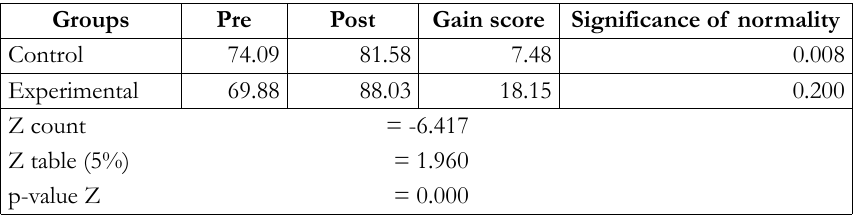
Table 7. The Mean Gain Score of Pedagogical